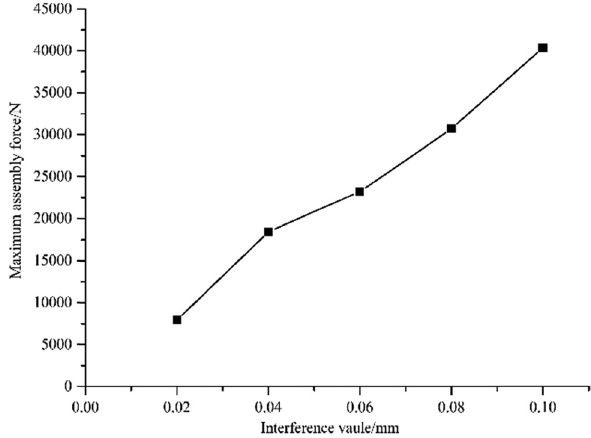
Figure 12: Relationship between maximum assembly force and interference